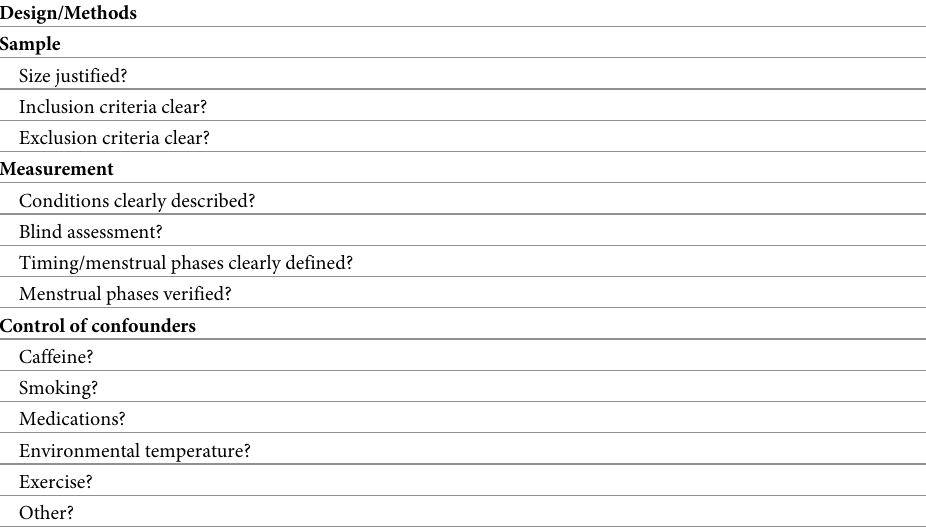
Table 1. Quality assessment questions for risk of bias based on study limitations in observational